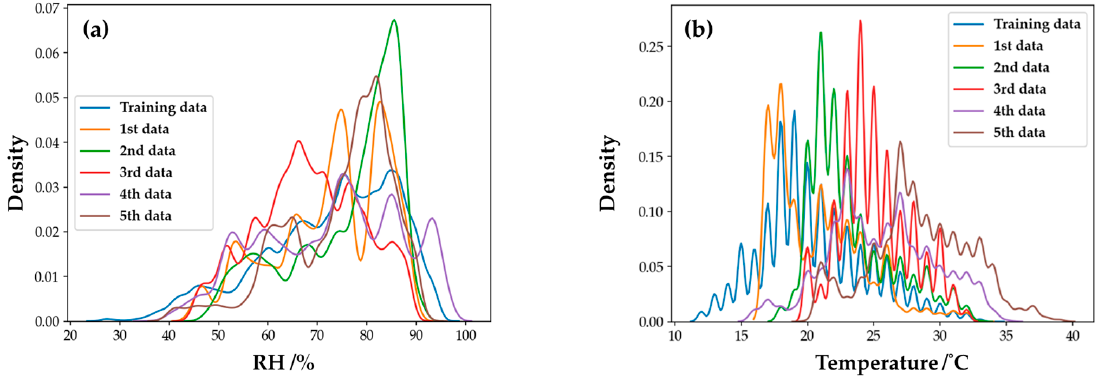
Figure 19. Distribution of ( a ) humidity and ( b ) temperature in each period.